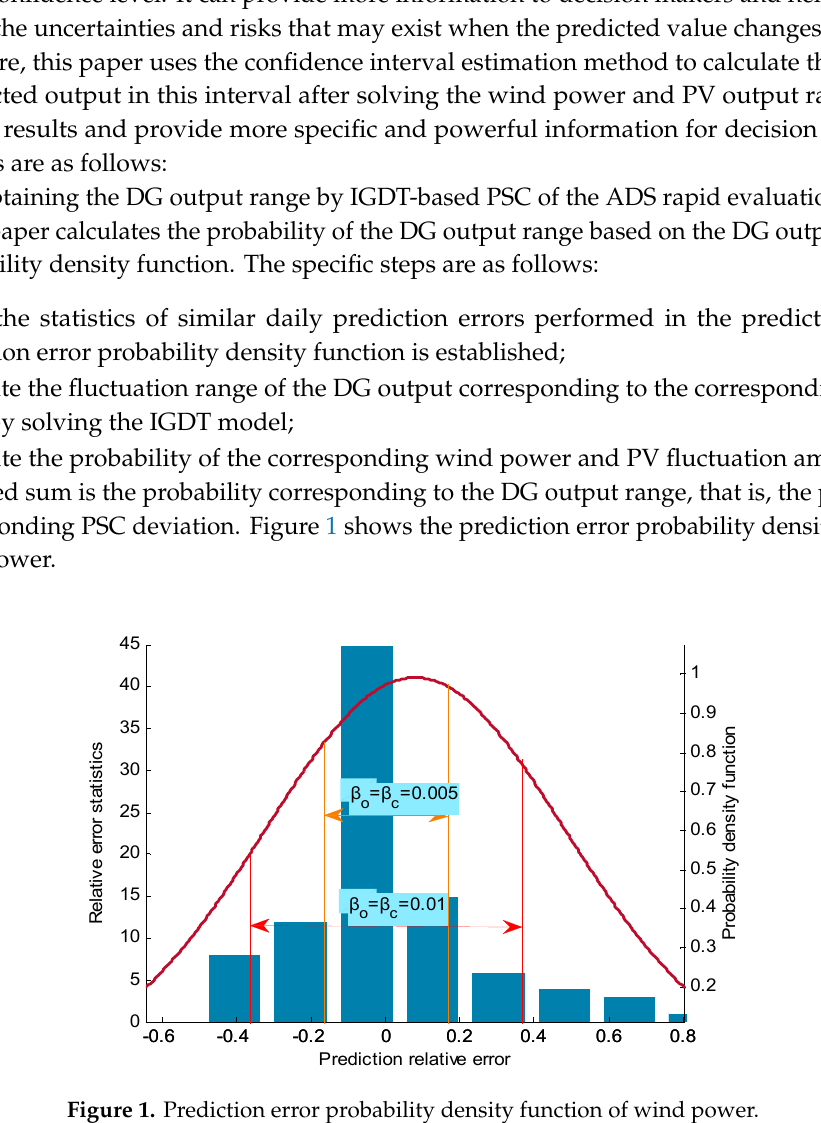
Figure 1. Prediction error probability density function of wind power.